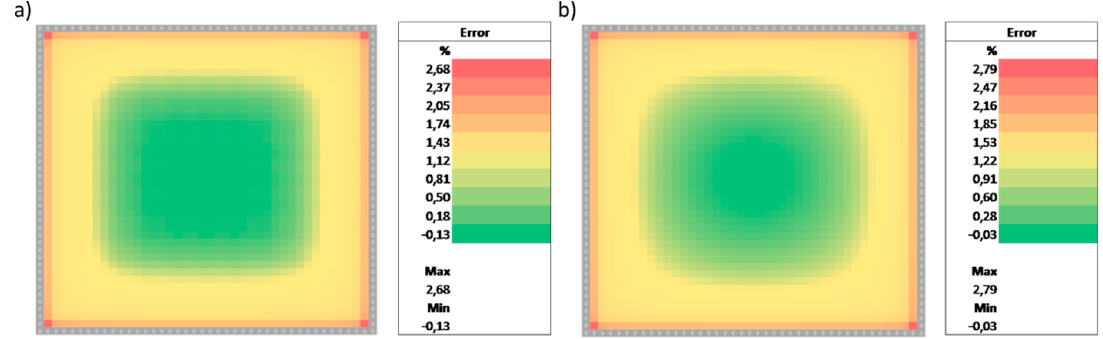
Figure 3. Comparison of the results obtained from the numerical scheme implemented in Microsoft Excel against the analytical solution of Equation (30) for time point 100 µs ( a ) and 1000 µs ( b ). The graphs show the relative error. Both cases show very good agreements with maximum errors below 3%.